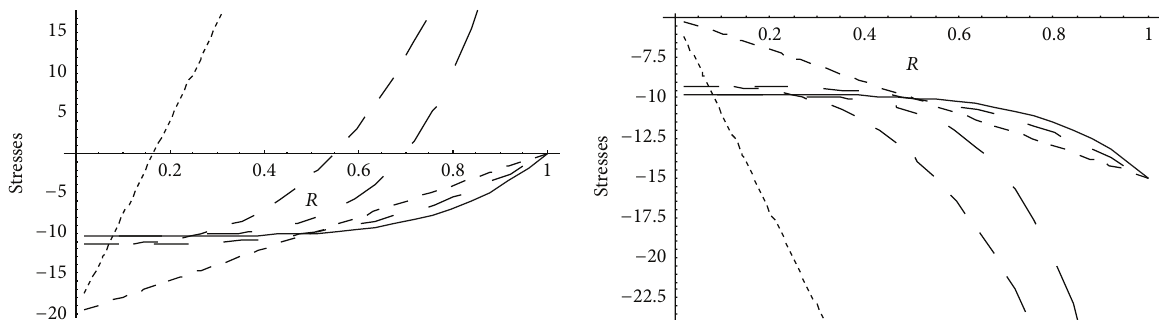
Figure 16: Nonhomogeneous fully plastic stresses for a thick-walled circular cylinder under internal ( 𝑃 1 = 10 ) and external pressure ( 𝑃 2 = 0 and